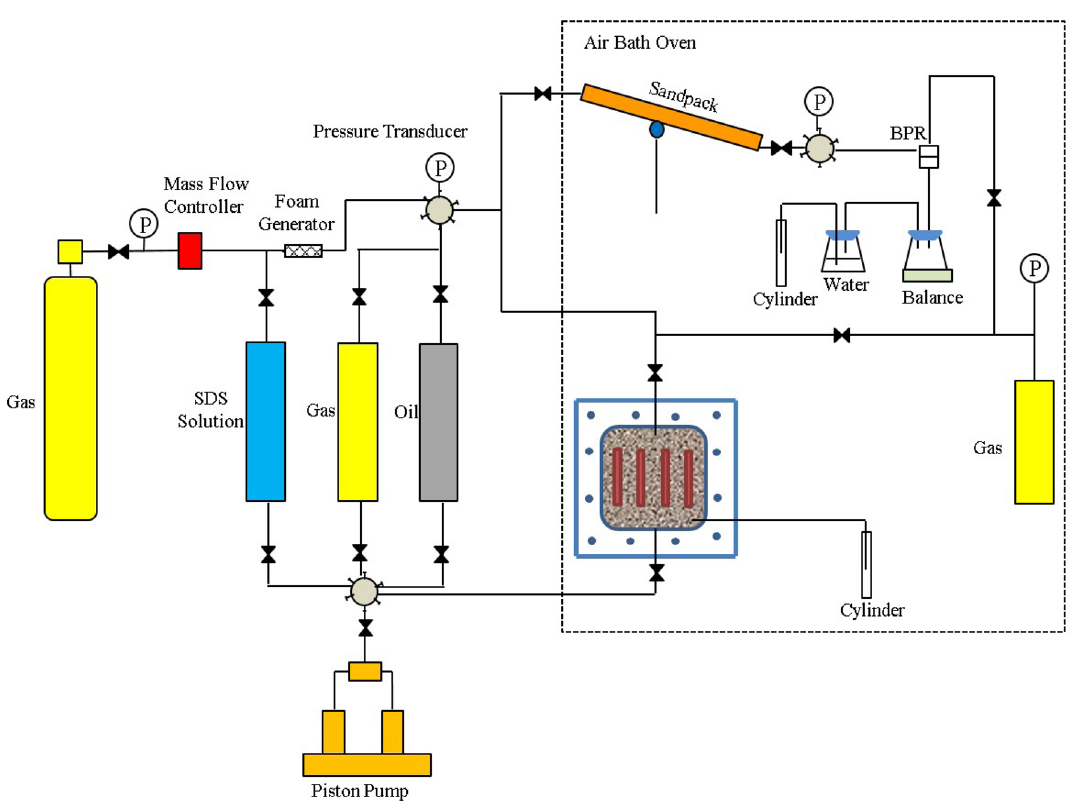
Fig. 1 Schematic of the experimental apparatus